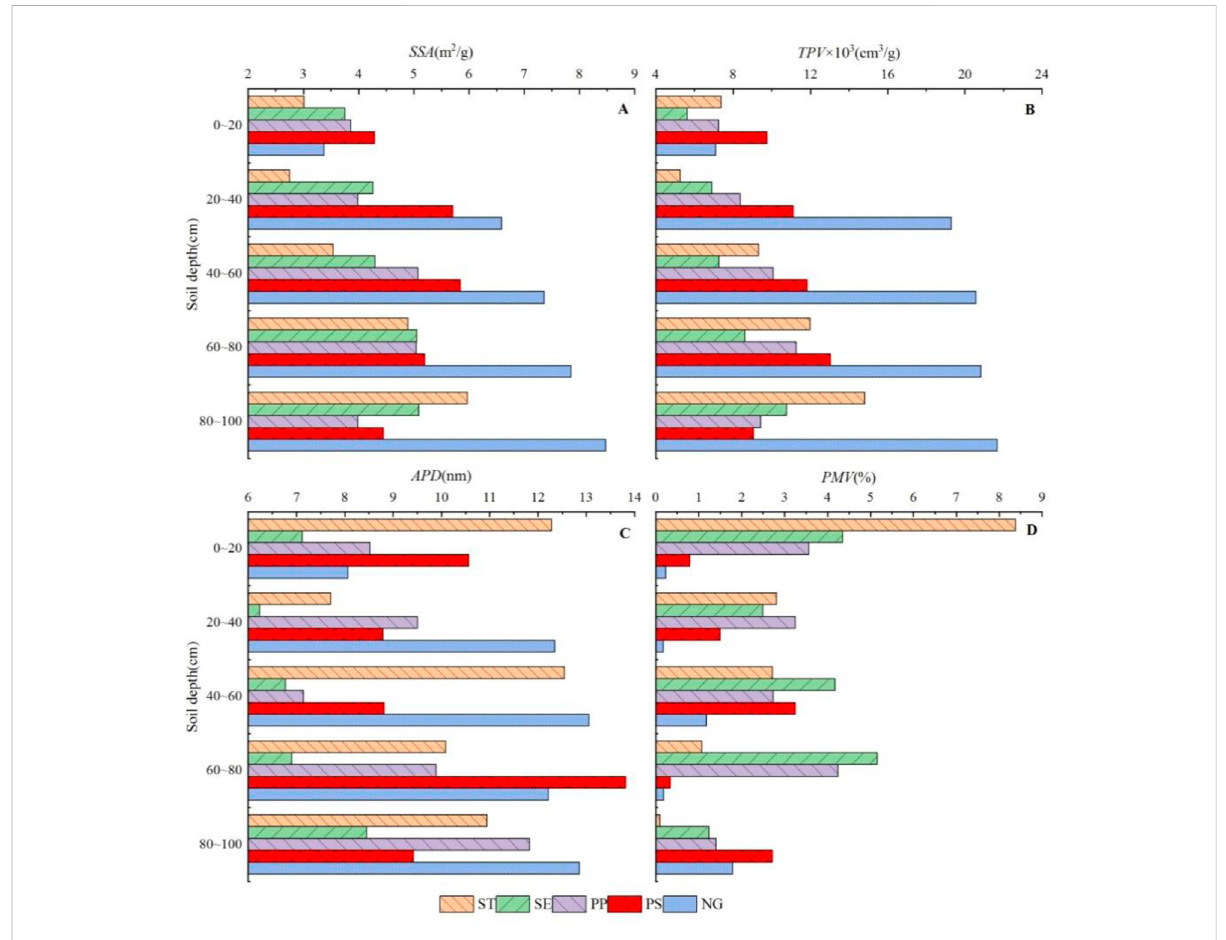
FIGURE 7 Nanopore parameters: (A) BET surface area ( SSA ), (B) BJH adsorption total pore volume ( TPV ), (C) average pore diameter ( APD ), and (D) percentage of micropore volume ( PMV ) of different soil layers under each vegetation